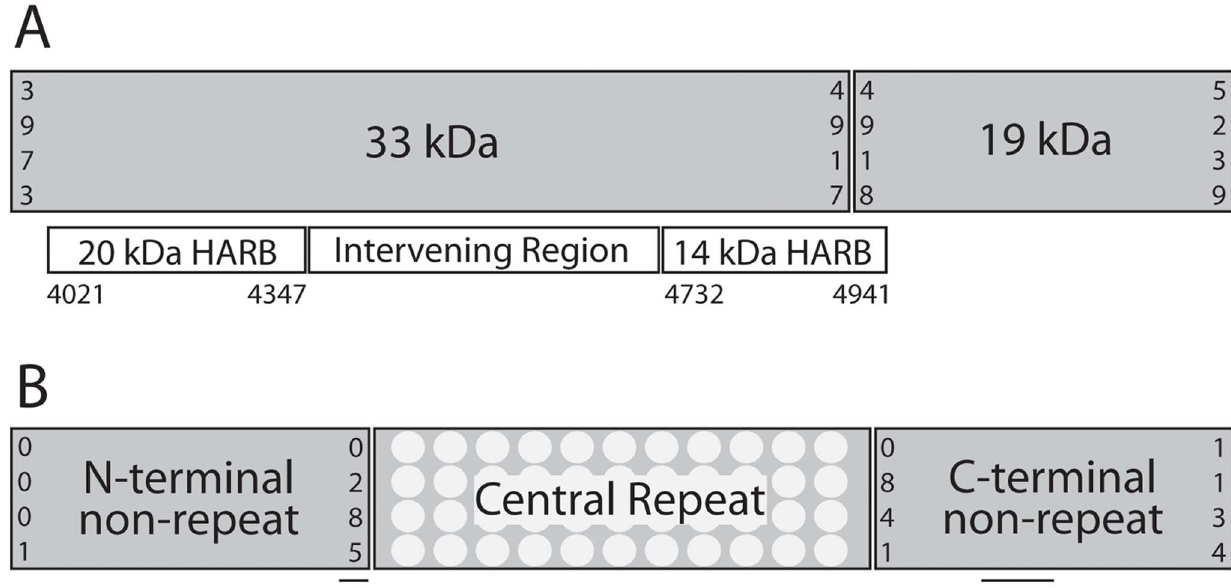
Figure 1. Protein domains and immunologically-relevant regions of pvmsp-1 42 kDa region and pvcsp . For both genes, numbers indicate coordinates according to the Sal1 reference genes. Sequences for pvmsp-1 (PVX_099980) and pvcsp (PVX_119355) were accessed August 14, 2012 from PlasmoDB.org. ( A ) The pvmsp-1 42 kDa region is composed of two primary subunits – a 33 kDa and a 19 kDa subunit. Other sub-regions, including the 20 kDa and 14 kDa HARBs have been previously defined and studied. Here, we define the region between the HARBs as the ‘‘intervening region.’’ ( B ) The pvcsp gene is composed of three regions – an N-terminal non-repeat region, a central repeat region, and a C-terminal non-repeat region. The central repeat region consists of two major nonapeptide repeat types, termed VK210 and VK247. Approximate locations of pvcsp regions I and II are noted with horizontal lines in the N- and C-terminal non-repeat regions, respectively.